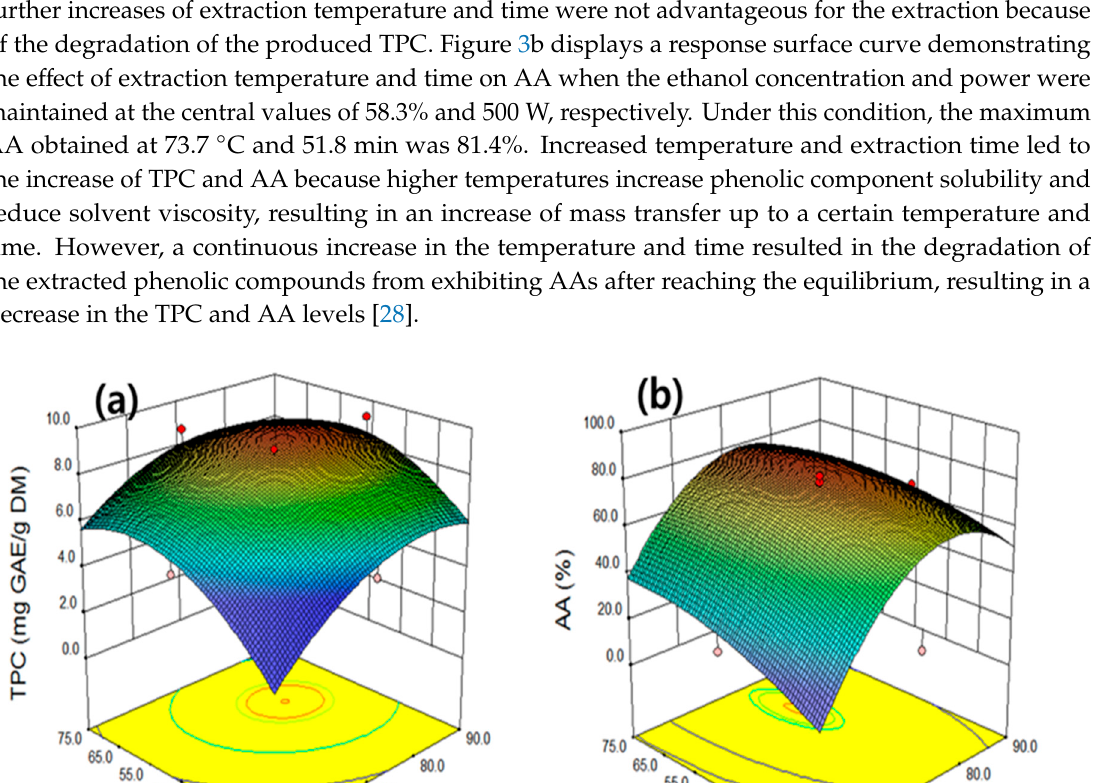
Figure 2. The interactive effects of the extraction temperature and ethanol concentration on total phenolic compounds ( a ) and antioxidant activity ( b ) at fixed levels of extraction time 45 min and ultrasonic power 500 W.